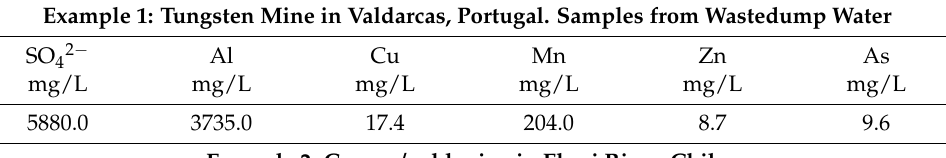
Table 1. Examples of concentration of some pollutants analyzed in mining water. Data from